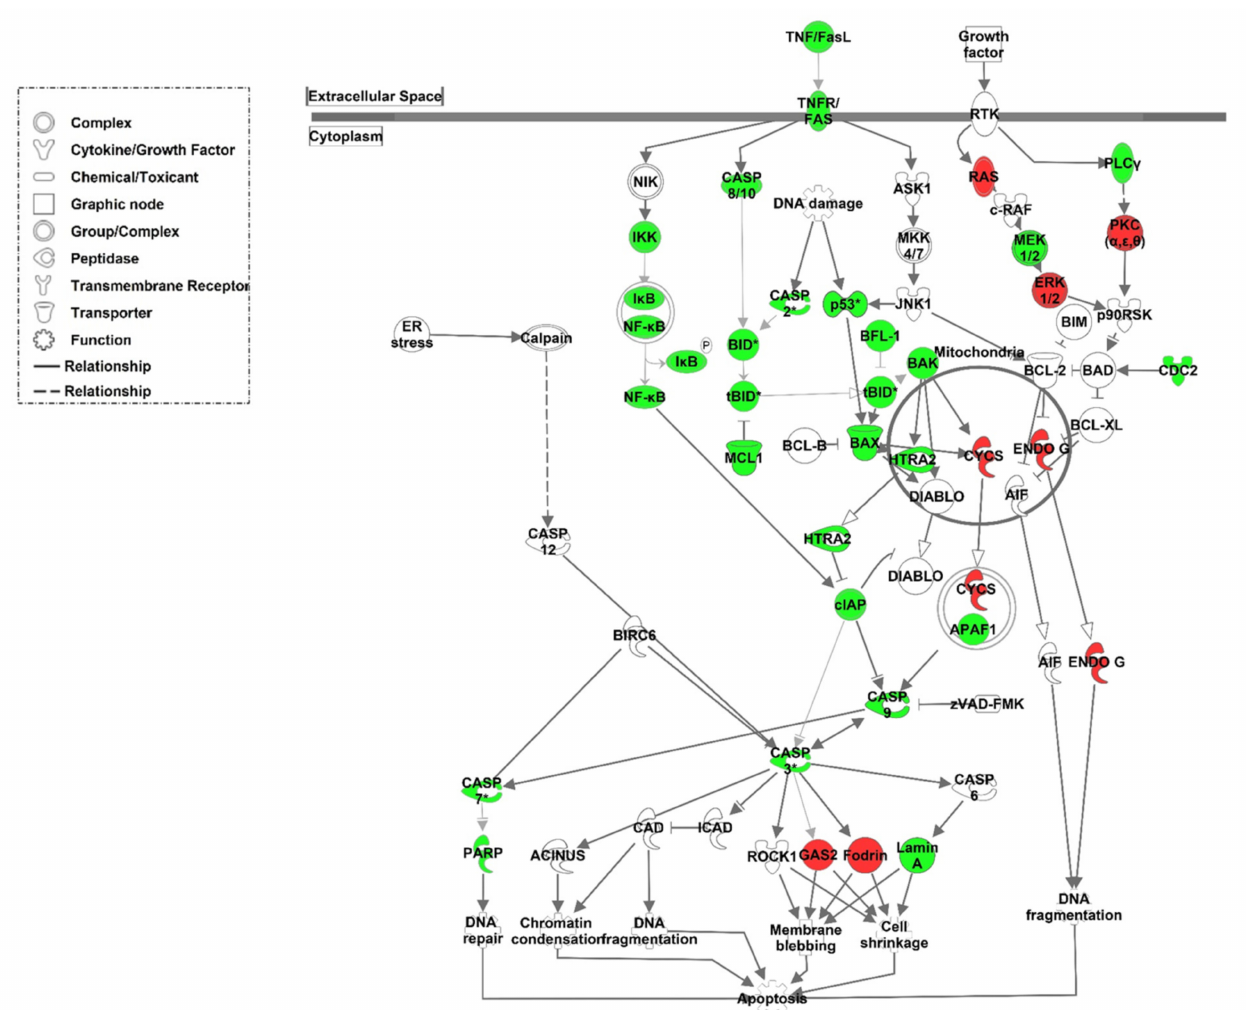
Figure 6. Induced expression of genes involved in death receptor signalling. Ingenuity Pathways Knowledge Base was used to display pathways containing multiple differently expressed genes. Significantly regulated genes after allogeneic transplantation compared to syngeneic transplantation were mapped with the death receptor signalling pathway. The lines indicate the type of relationships. Solid lines indicate a direct and dotted lines an indirect interaction. Upregulated genes are highlighted in green, downregulated genes are highlighted in